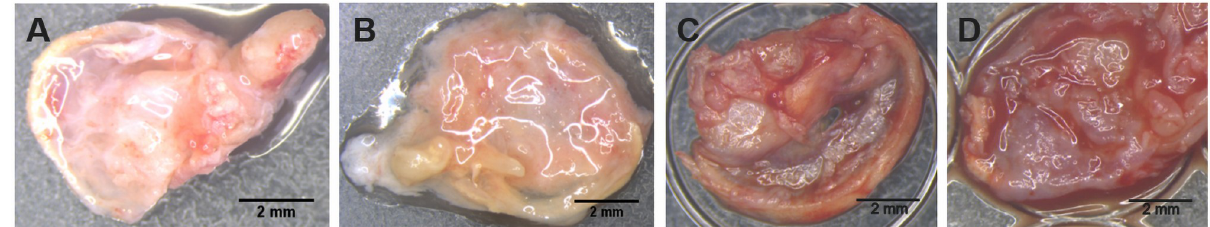
Fig 2. Human tympanic membranes after preparation. ( A ) Tympanic membrane with attached malleus cleaned as good as possible before measurements. ( B-D ) Tympanic membranes as received from the OR without malleus.